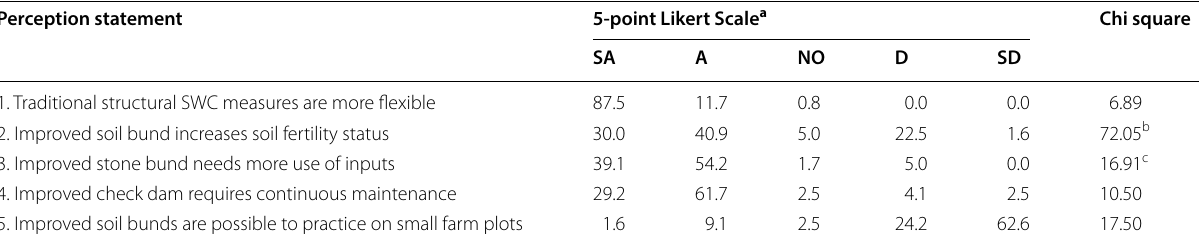
Table 4 Distribution of farmers’ perception on structural SWC measures (5-point Likert-scale) Source : Own analysis from survey data,